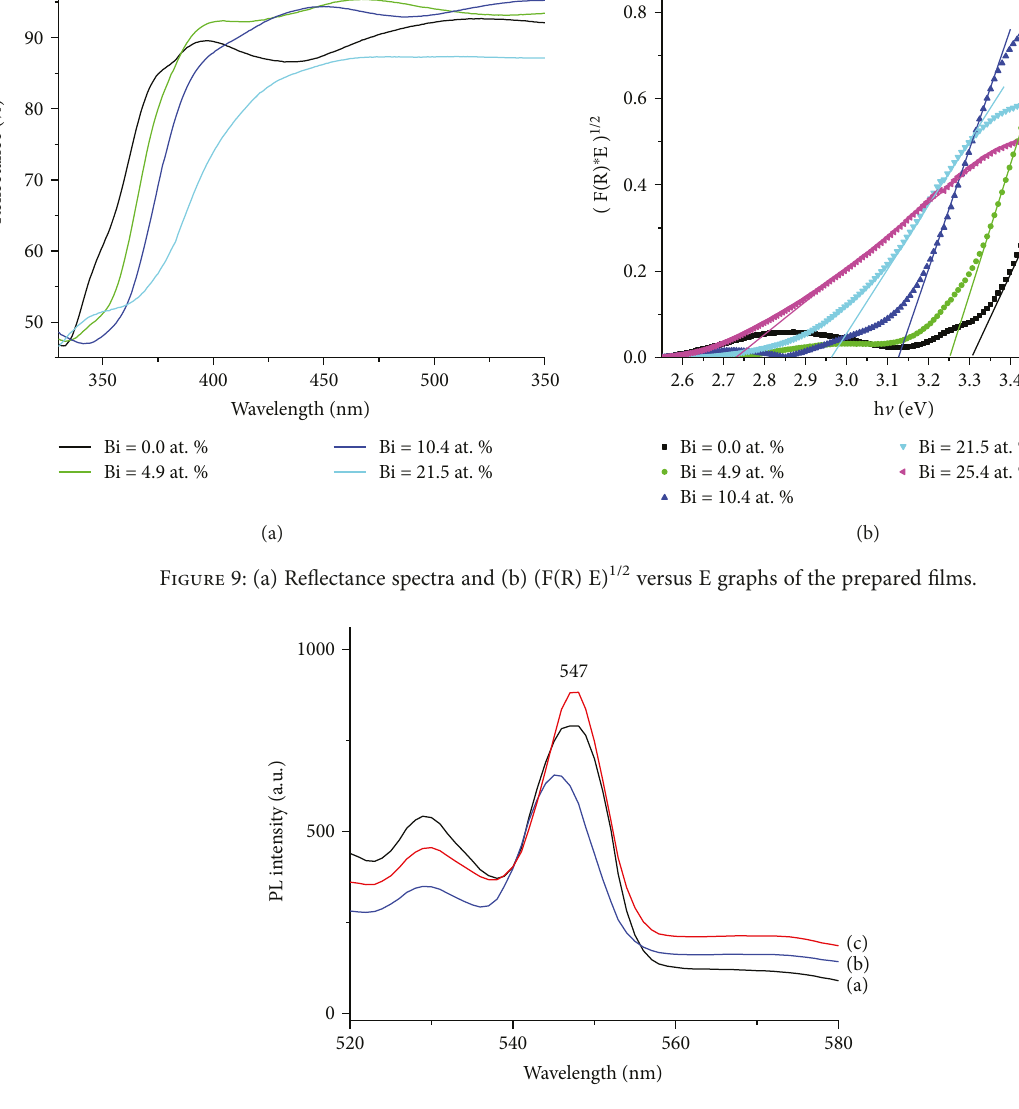
Figure 10: Photoluminescence spectra of (a) 0, (b) 21.5, and (c) 25.4 at. % of